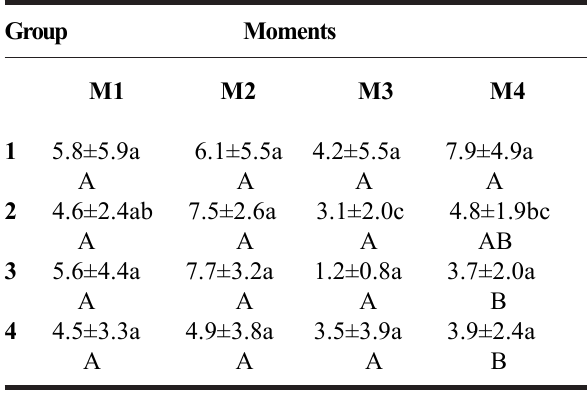
the groups into each moment.